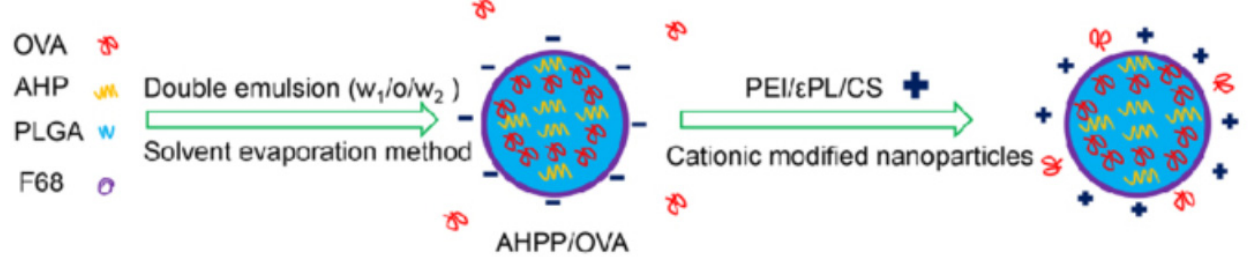
Figure 9. Schematic representation of OVA-loaded surface cationic polymer modified AHPP/OVA nanoparticles. Reprinted from an open-access source [317].